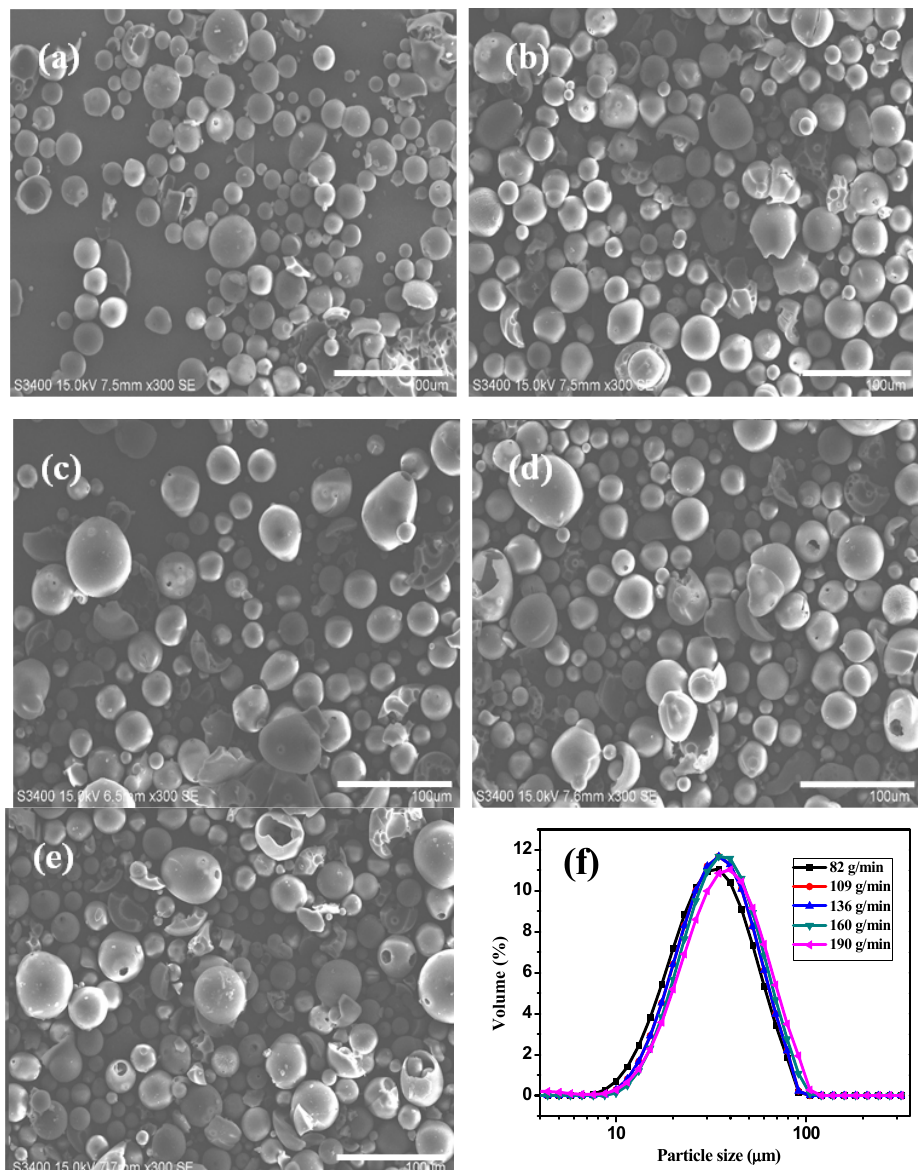
Figure 5. Effects of feed rate on particle size, size distribution, and morphology of the formed polyacrylate hollow microspheres: ( a ) 82 g/min; ( b ) 109 g/min; ( c ) 136 g/min; ( d ) 160 g/min, and ( e ) 190 g/min; ( f ) Particle size distribution as a function of feed rate.